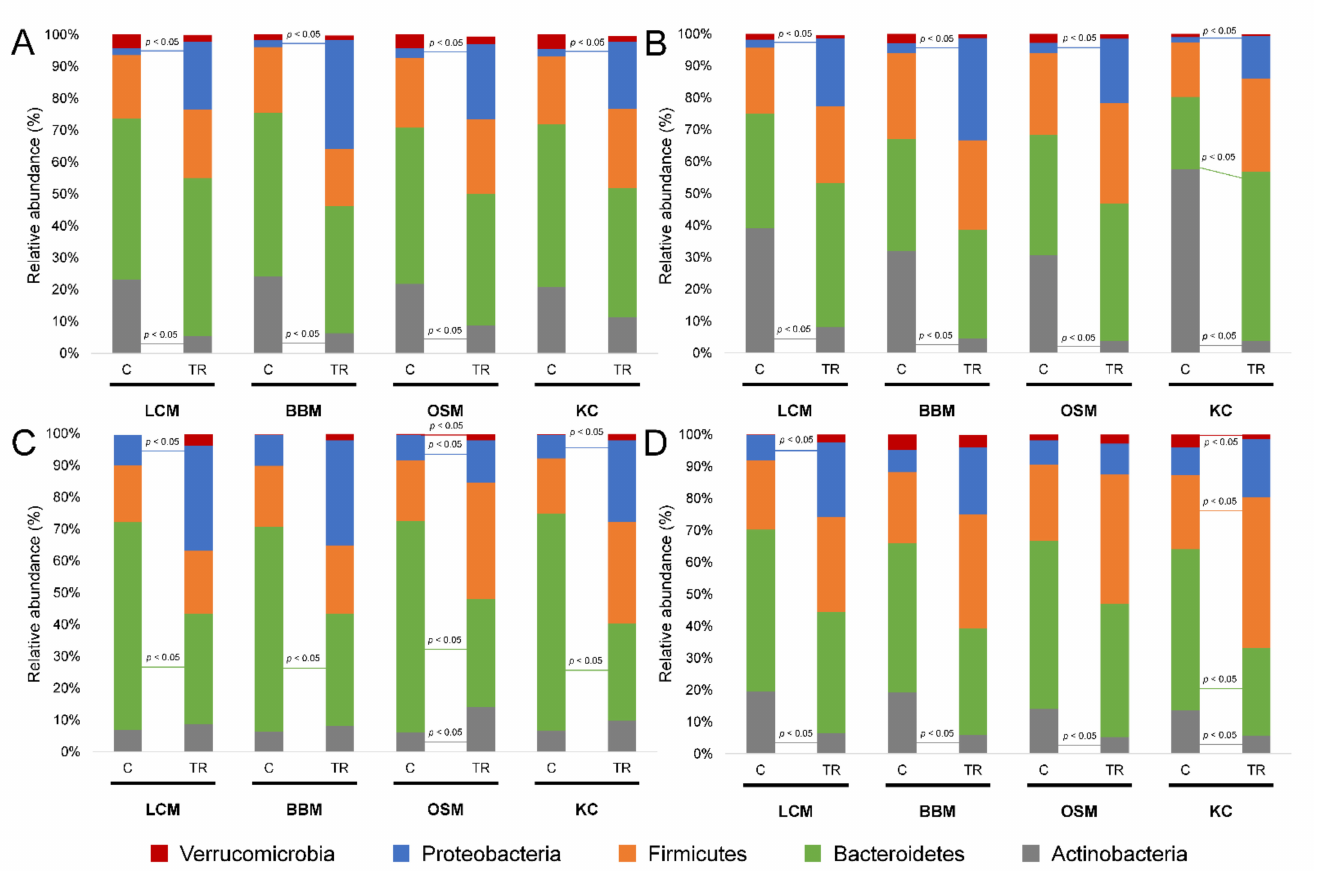
Figure 3. Changes in microbial community composition (relative abundance) at the phylum level in the luminal PC and DC for ( A ) Donor A, luminal PC; ( B ) Donor B, luminal PC; ( C ) Donor A, luminal DC; ( D ) Donor B, luminal DC. BBM = berry blast muffin; C = control period; DC = distal colon; KC = Kodiak cake; LCM = lemon chia muffin; OSM = oat spice mookie; PC = proximal colon; TR = treatment